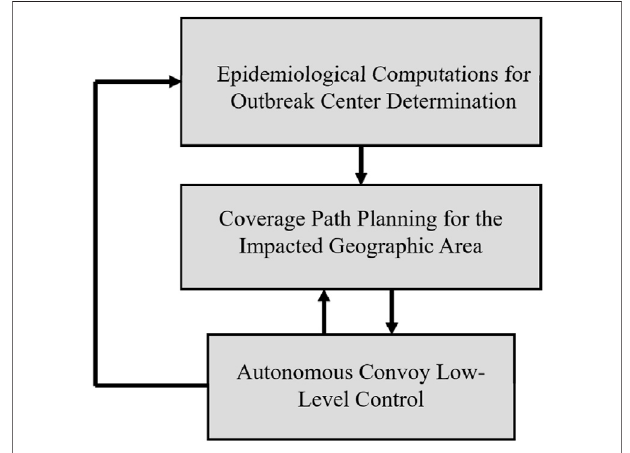
FIGURE1| Ahierarchicaldecision-makingframeworkfordeploymentof military AGCs in combat against